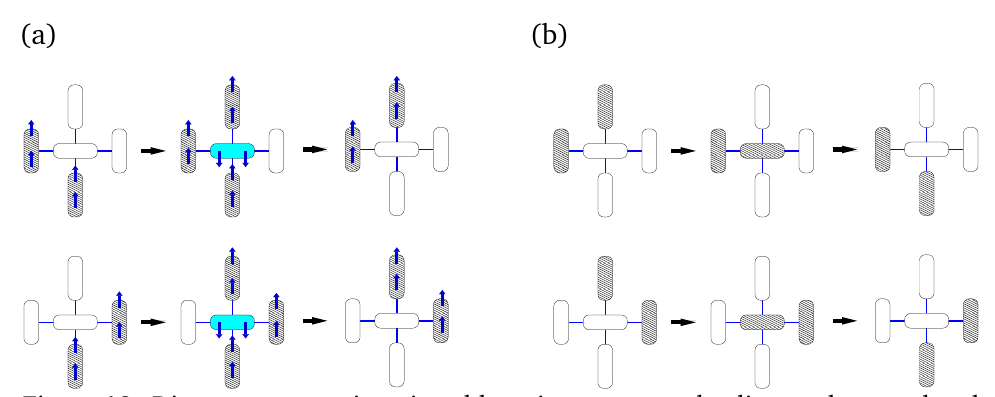
Figure 12: Diagrams presenting virtual hopping processes leading to the correlated hopping term in the effective Hamiltonian (6). Panels (a) and (b) correspond to Eqs. (B.15) and (B.16). The shaded ovals correspond to the triplons with S z = − 1 or S z i , j